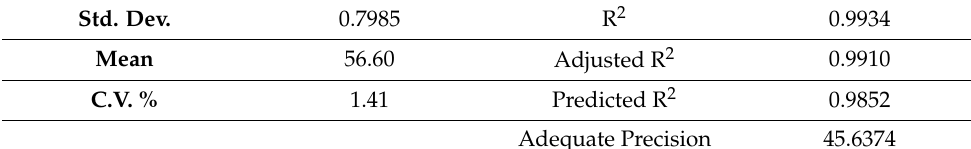
Table 5. Fit statistics for the model.